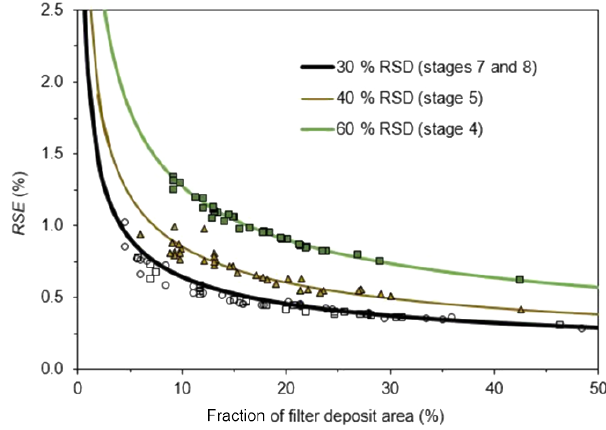
√ P ) as a fraction